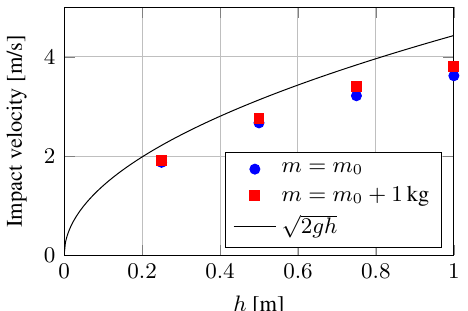
Figure 7. Impact velocity of the specimen as a function of the drop height and of the mass of the impacting cylinder.